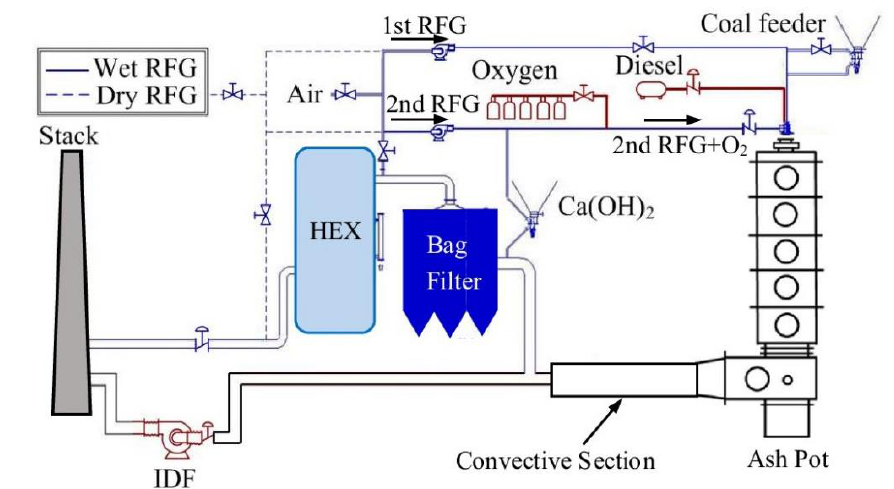
Figure 1. Configuration of the 0.3 MW th multi-fuel combustion test facility. HEX: heat exchanger; IDF: induced draft fan.